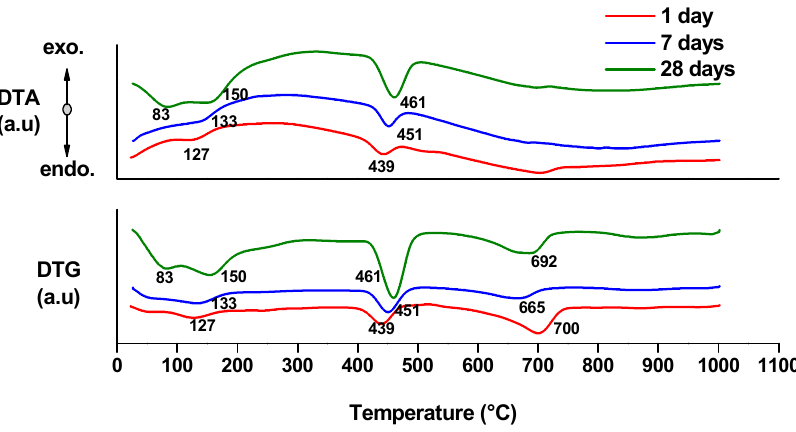
Figure 5. DTA and DTG curves of MTA1 paste hydrated for 1, 7 and 28 days.